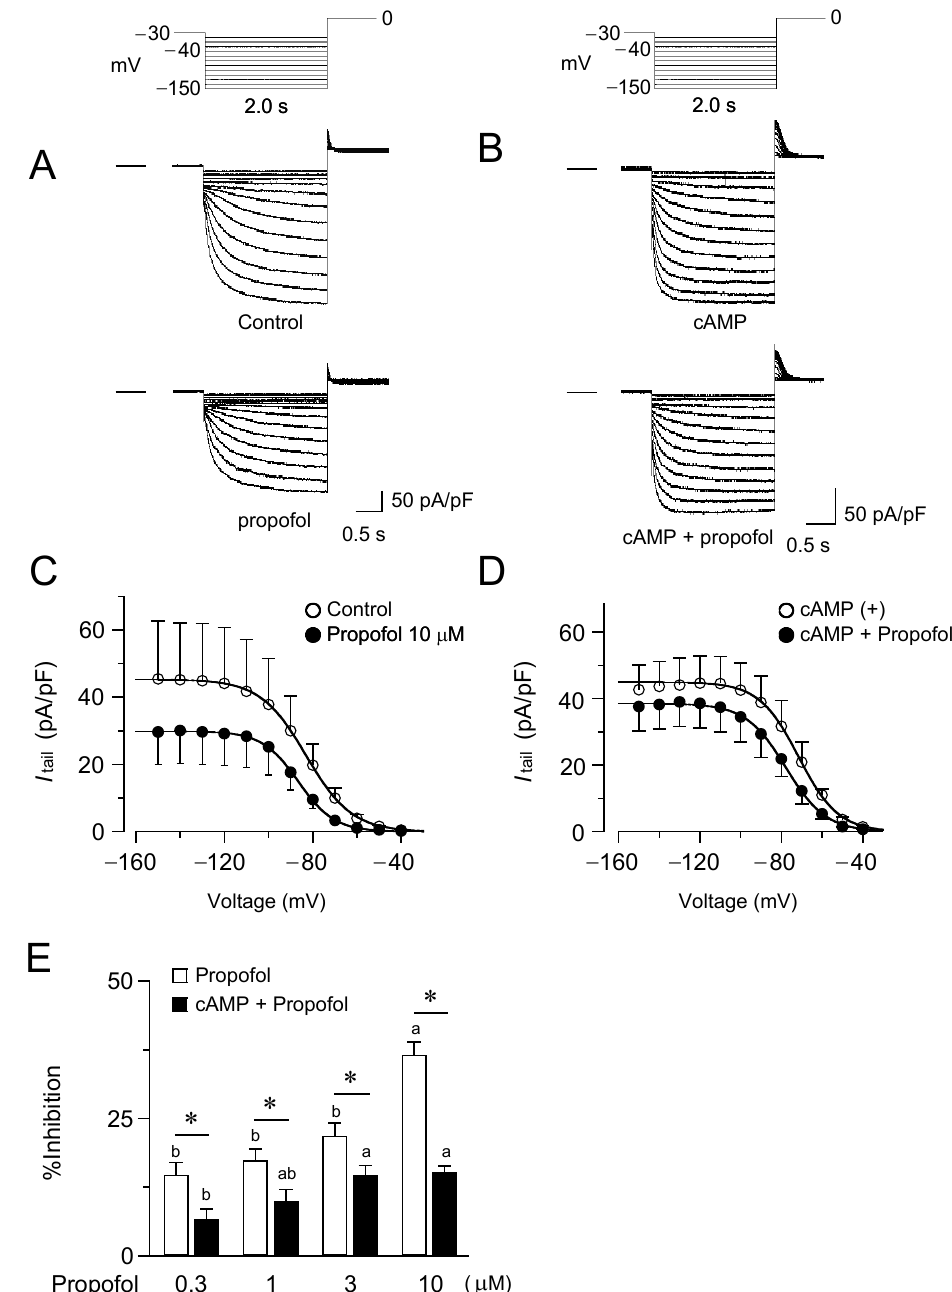
Figure 1. Inhibitory effects of propofol on HCN4 channels. ( A ) Superimposed current traces